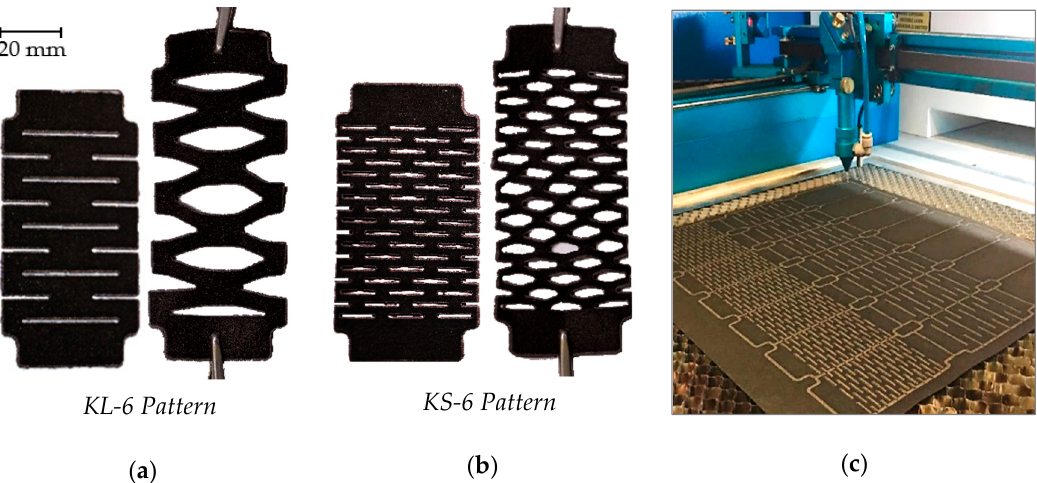
Figure 7. Kirigami fabric designs. ( a ) Thermionyx fabric kirigami larger cut pattern; Left: Relaxed state; Right: Stressed state, held in place by alligator clips. ( b ) Thermionyx fabric kirigami smaller cut pattern; Left: Unstressed state; Right: Stressed state, held in place by alligator clips. ( c ) Thermionyx fabric patterns being manufactured by the Thunder Laser Nova 35 laser cutter. Laser settings at 40% power at 50 mm/s, running two passes.